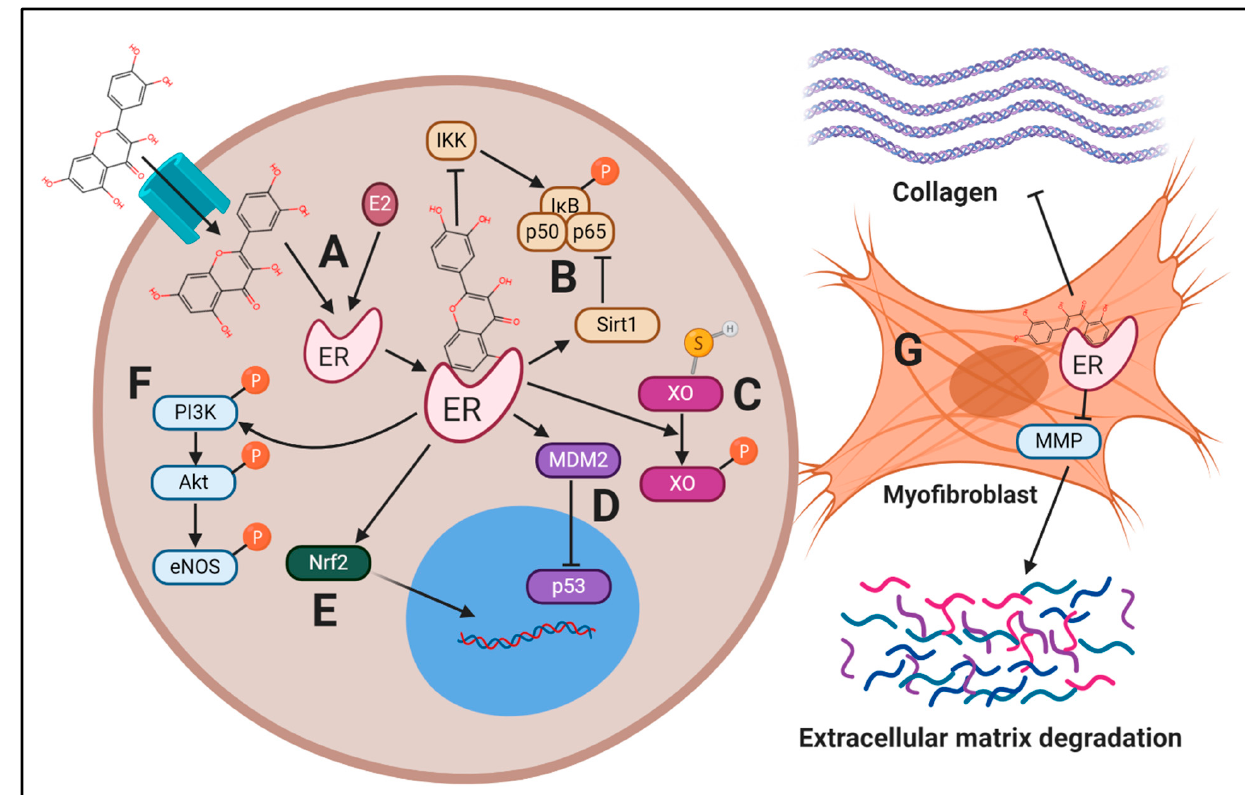
Figure 2. Potential estrogen receptor-mediated effects by berry polyphenols in CVD. Multiple cellular targets are me- diated by the estrogen receptor (ER), acting in an overall protective manner. ( A ) Polyphenols derived from berries, such as quercetin, can enter the cell via bilitranslocase and act as ER ligands in a similar fashion to 17 β -estradiol (E2). (B) Once ER is activated, it inhibits I κ B kinase (IKK)-mediated I κ B phosphorylation and degradation, preventing nuclear translocation of NF- κ B subunits, p65 and p50. Additionally, ER recruits Sirt1 to induce deacetylation of nuclear factor kappa-light-chain-enhancer of activated B (NF- κ B), further inhibiting its activity. ( C ) The active sulfhydryl form of xanthine oxidase (XO) undergoes posttranslational modifications by ER, hydrolyzing the sulfhydryl group and inducing phosphory- lation of XO, inhibiting its activity and reducing ROS. ( D ) Murine double minute 2 (MDM2) activity is upregulated by ER, leading to increased p53 degradation, reducing apoptosis. ( E ) ER increases nuclear factor erythroid 2-related factor (Nrf2) nuclear activity, increasing endogenous detoxifying enzymes. ( F ) Activity of endothelial nitric oxide synthase (eNOS) is increased due to phosphorylation by phosphoinositide 3-kinase (PI3K)/protein kinase B (Akt) mediated by ER. ( G ) Fibrosis is reduced in myofibroblasts due to ER-mediated effects on matrix metalloproteinase (MMP) and collagen, decreasing the expression of these proteins. Thus, berry polyphenols may be protective partially due to ER-dependent activity. Created in BioRender.com.